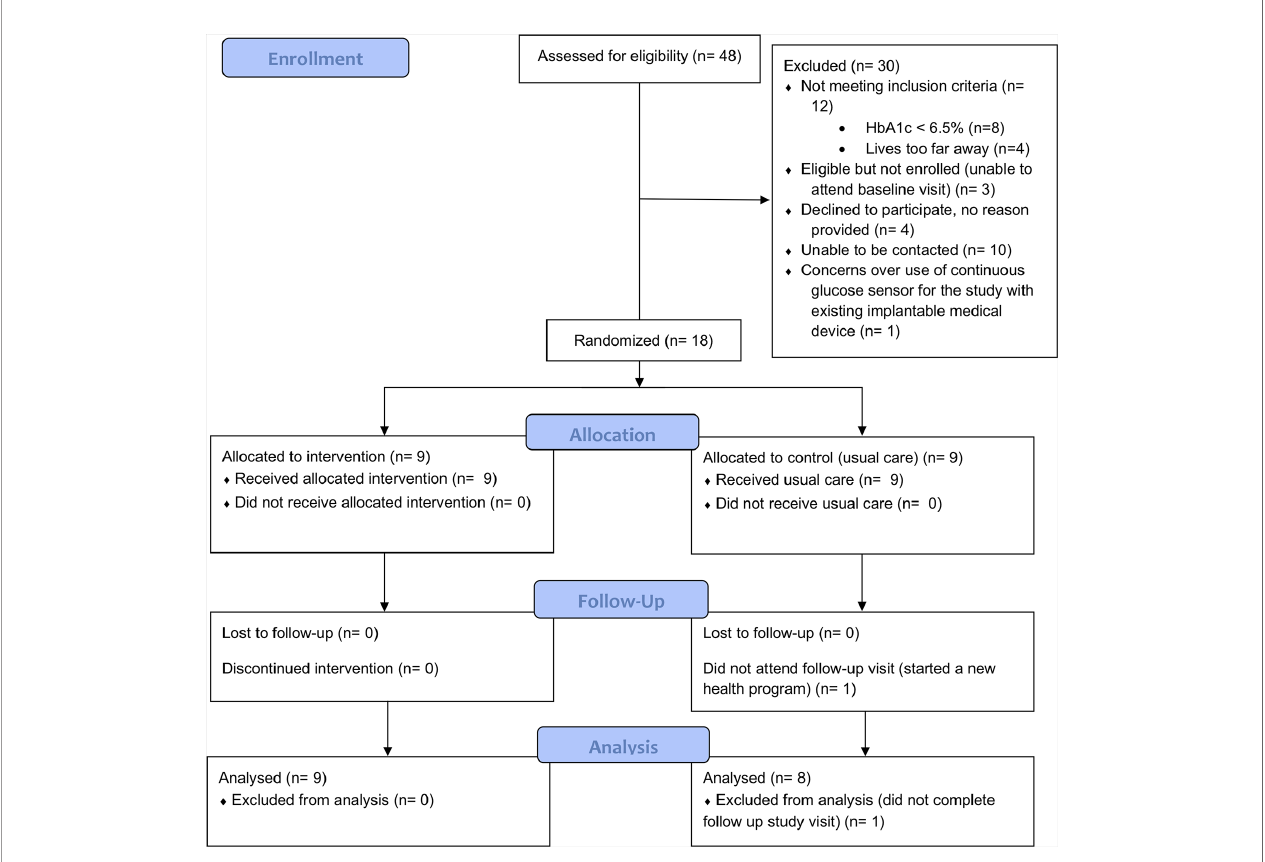
FIGURE 1 | CONSORT fl owchart of participant fl